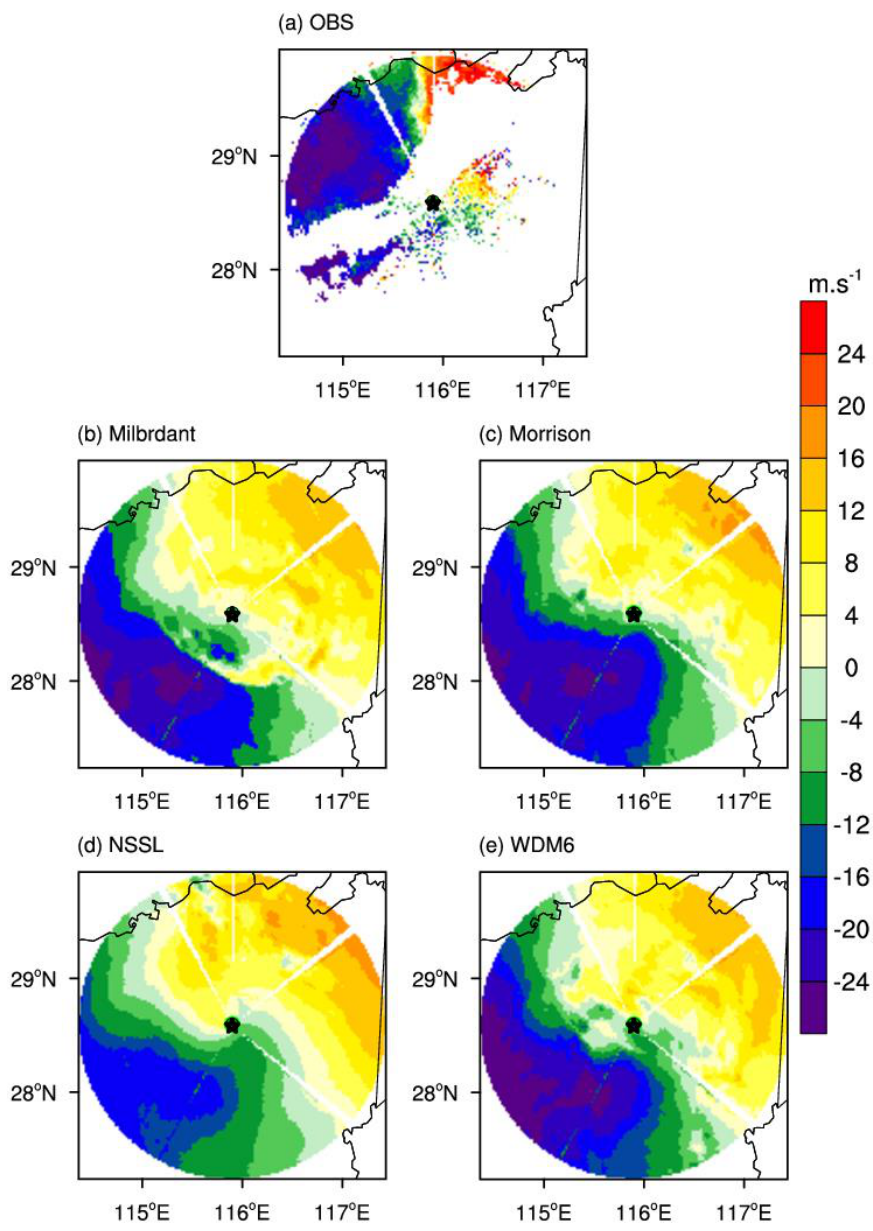
Figure 13. The radial velocity (shaded, units: m·s −1 ) at the lowest elevation (0.5°) of the Nanchang radar station with different experiments and the radar observation at 2230 UTC 15 April 2016. The location of the radar station (filled star).